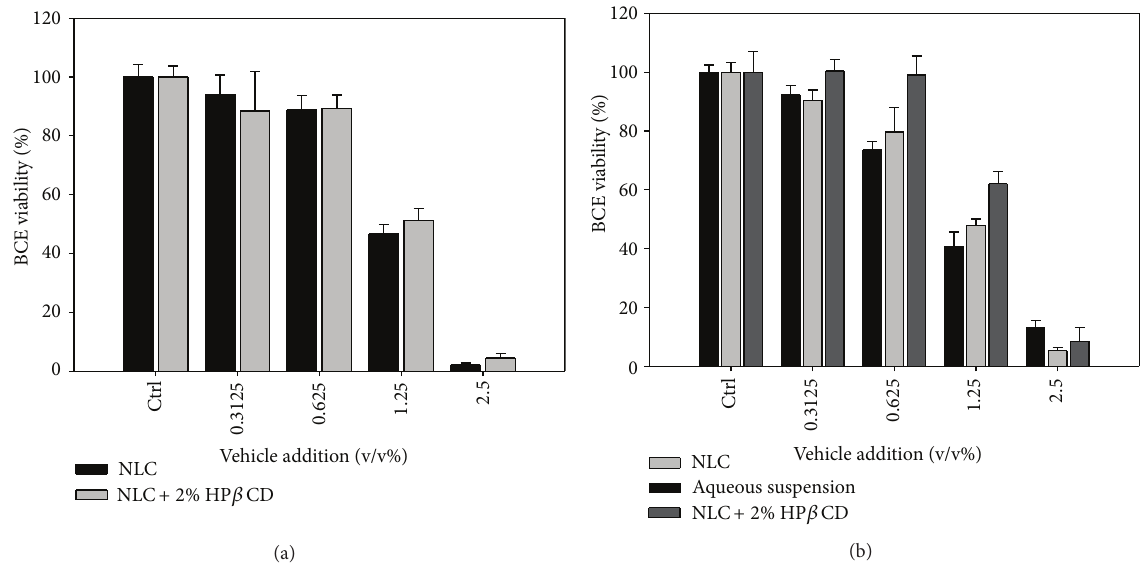
Figure 7: Cytotoxic effect of vehicles on bovine cornea epithelium cells: (a) vehicle only and (b) lutein loaded vehicles.